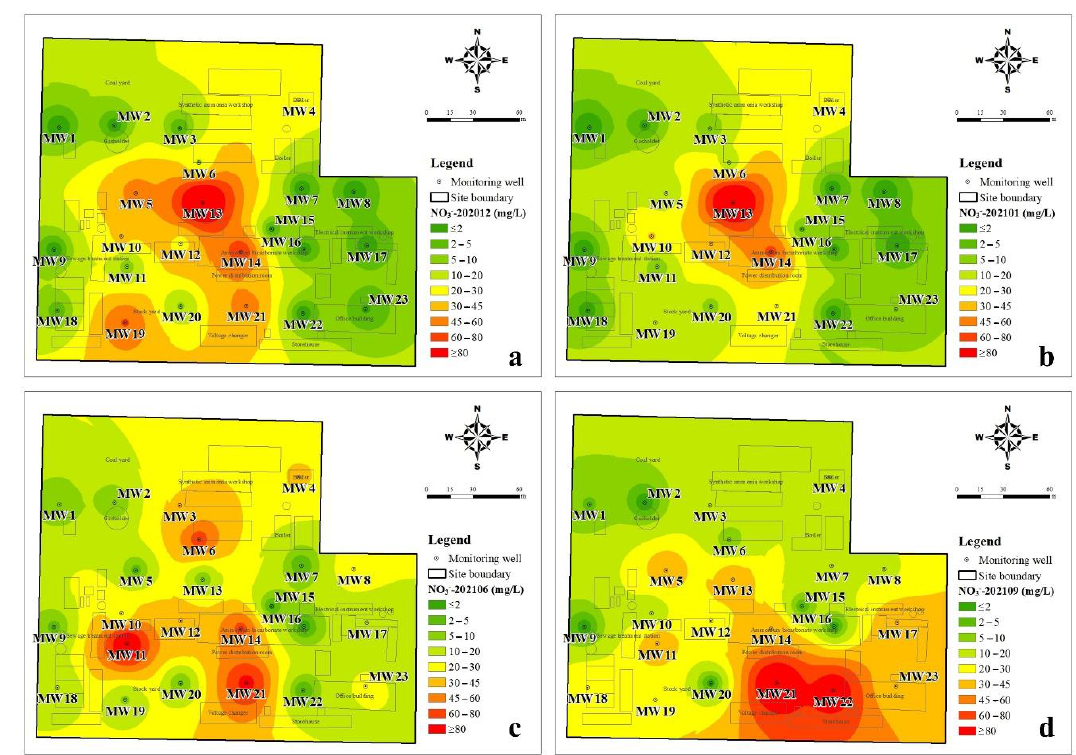
Figure 4. Interpolation diagram of ammonia-nitrogen in groundwater ( a ): in December 2020, ( b ): in January 2021, ( c ): in June 2021, ( d ): in September 2021.